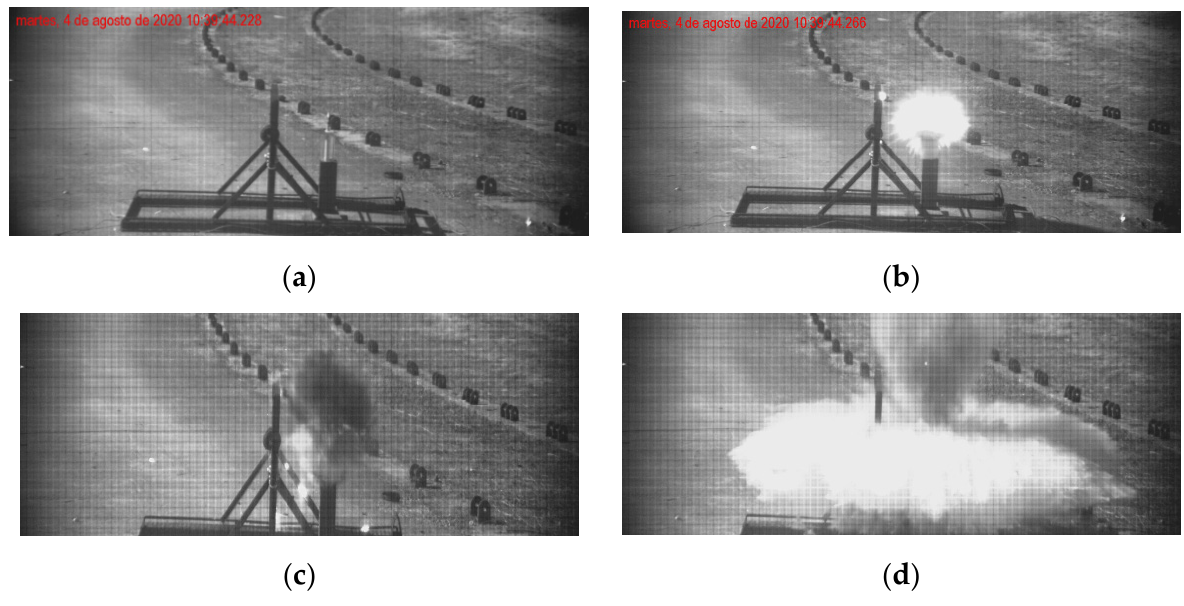
Figure 7. Images of test 1 taken by the high-speed camera at 6000 fps. ( a ) Device prepared for detonation; ( b ) detonator explosion; ( c ) upper dark cloud formed by gases produced by the detonating cord; ( d ) disk of water projected by the effect of the explosion.